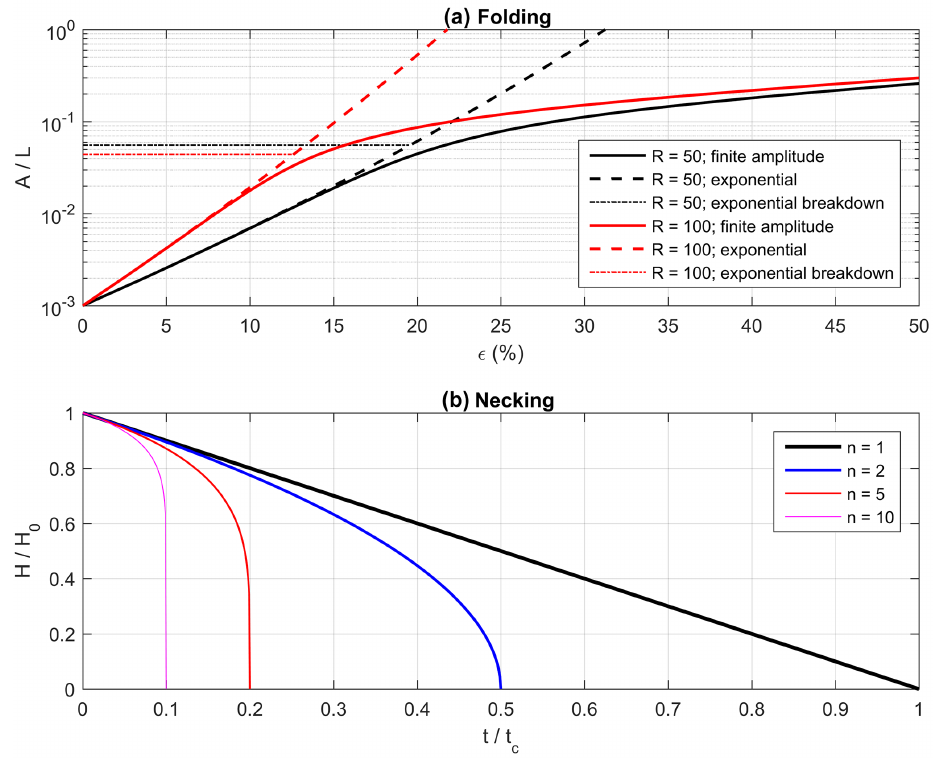
Figure 17. Approximate finite amplitude solutions for folding ( a ; Eq. 29) and necking ( b ; Eq. 41). For folding the layer and embedding medium are linear viscous, while for necking the layer is power-law viscous and not embedded in a viscous medium (free layer or embedded in inviscid medium). (a) Ratio of amplitude to wavelength ( A/L ) vs. horizontal bulk shortening ( ε in %) for a viscosity ratio ( R ) of 50 and 100. In Eq. (29) the ratio L 0 /L is used as a measure for shortening, which is related to the bulk shortening in % by ε = ( 1 − L/L 0 ) 100. The applied initial value is A 0 /L 0 = 0 . 001 for both viscosity ratios. Both the exponential and finite amplitude solution are plotted. The thin dashed-dotted lines indicate the breakdown of the exponential solution as quantified by Eq. (30). (b) Ratio of layer thickness to initial layer thickness ( H/H 0 ) vs. the dimensionless time ( t/t c ; see text below Eq. 41) for different values of the power-law exponent ( n ) of the layer. For n = 1 no necking instability is active and thinning is due to homogeneous pure shear thinning only. The time for complete thinning ( H/H 0 = 0) is given by t/t c = 1 /n (see